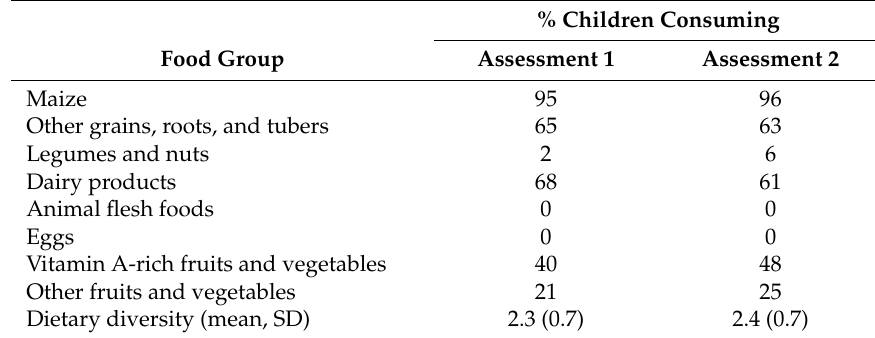
Table 2. Children’s consumption of key food groups and dietary diversity [27] in a 24-h period at each